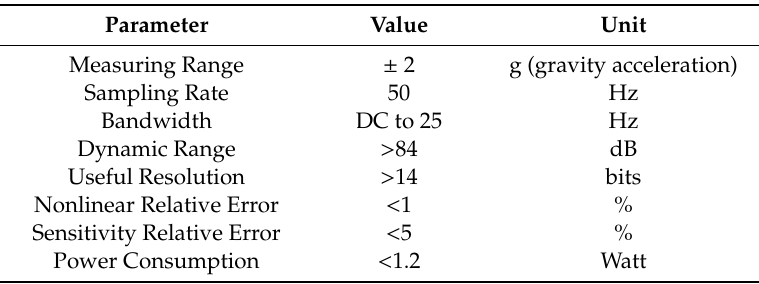
Table 1. The specifications of the MNSMS.